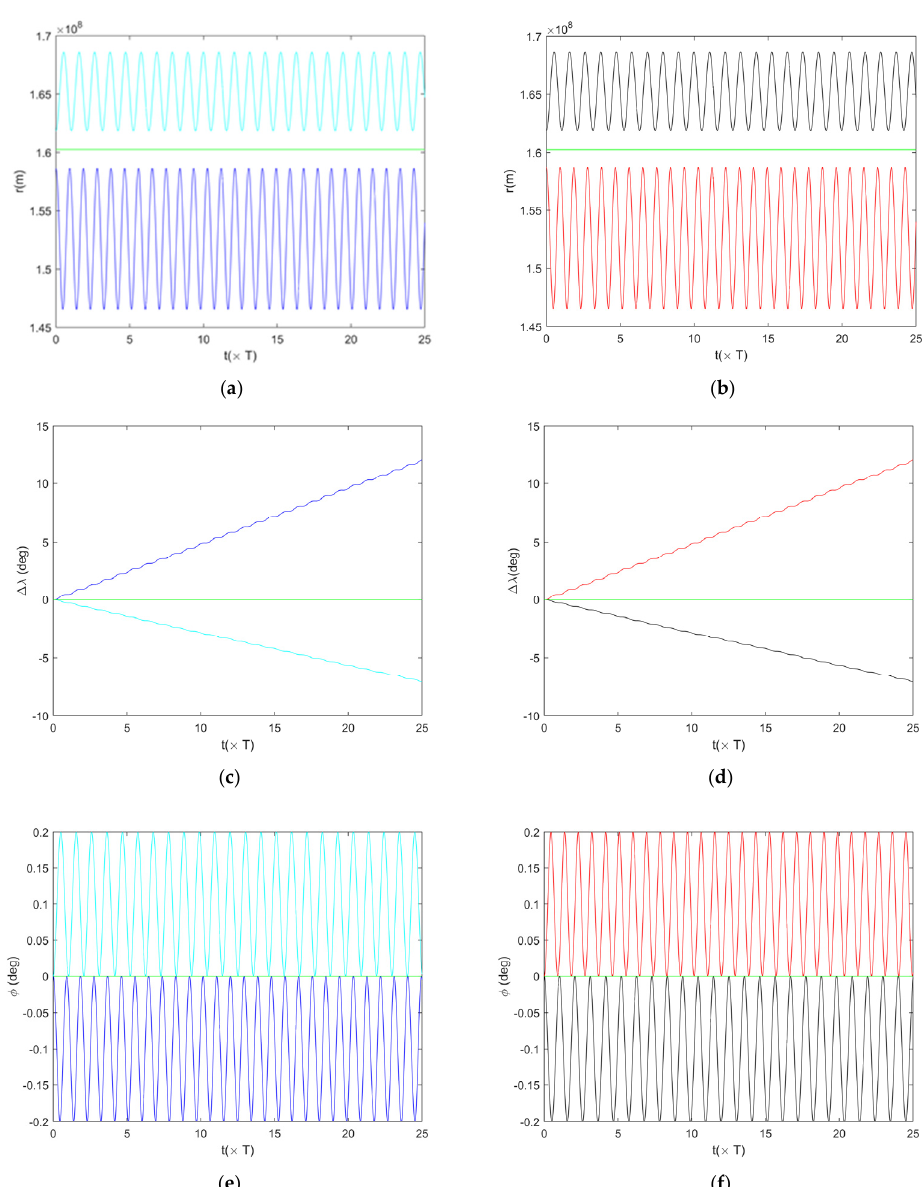
Figure 2. Orbits around Jupiter: green—stationary orbits; red— r = 0.99 r 0 , φ = − 0.1 deg; blue— r = 0.99 r 0 and φ = 0.1 deg; cyan— r = 1.01 r 0 and φ = − 0.1 deg; black— r = 1.01 r 0 and φ = 0.1 deg.